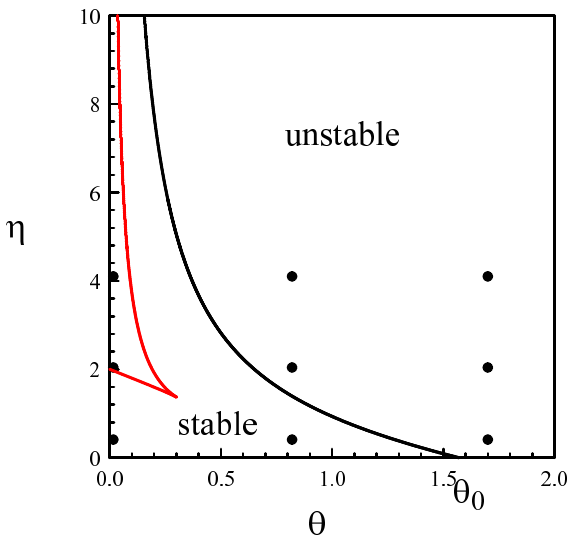
Figure 4. First Hopf bifurcation line delimiting the domain of stable steady states (black). It is given by (18) with n = 0. It contains a smaller domain where the decay to the steady state is purely exponential (red). The dots are the values of the parameters used by Statz et al. [8] in their numerical simulations. They are documented in Table A1.